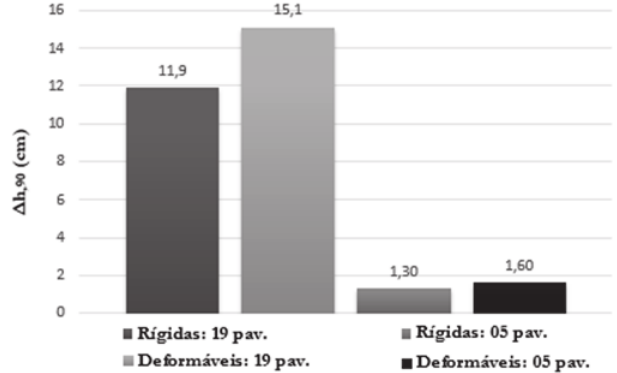
Figura 15 Modelo de Alva e El Debs [21]: deslocamento horizontal da estrutura com 19 e 5 pavimentos, considerando ligações rígidas e ligações deformáveis